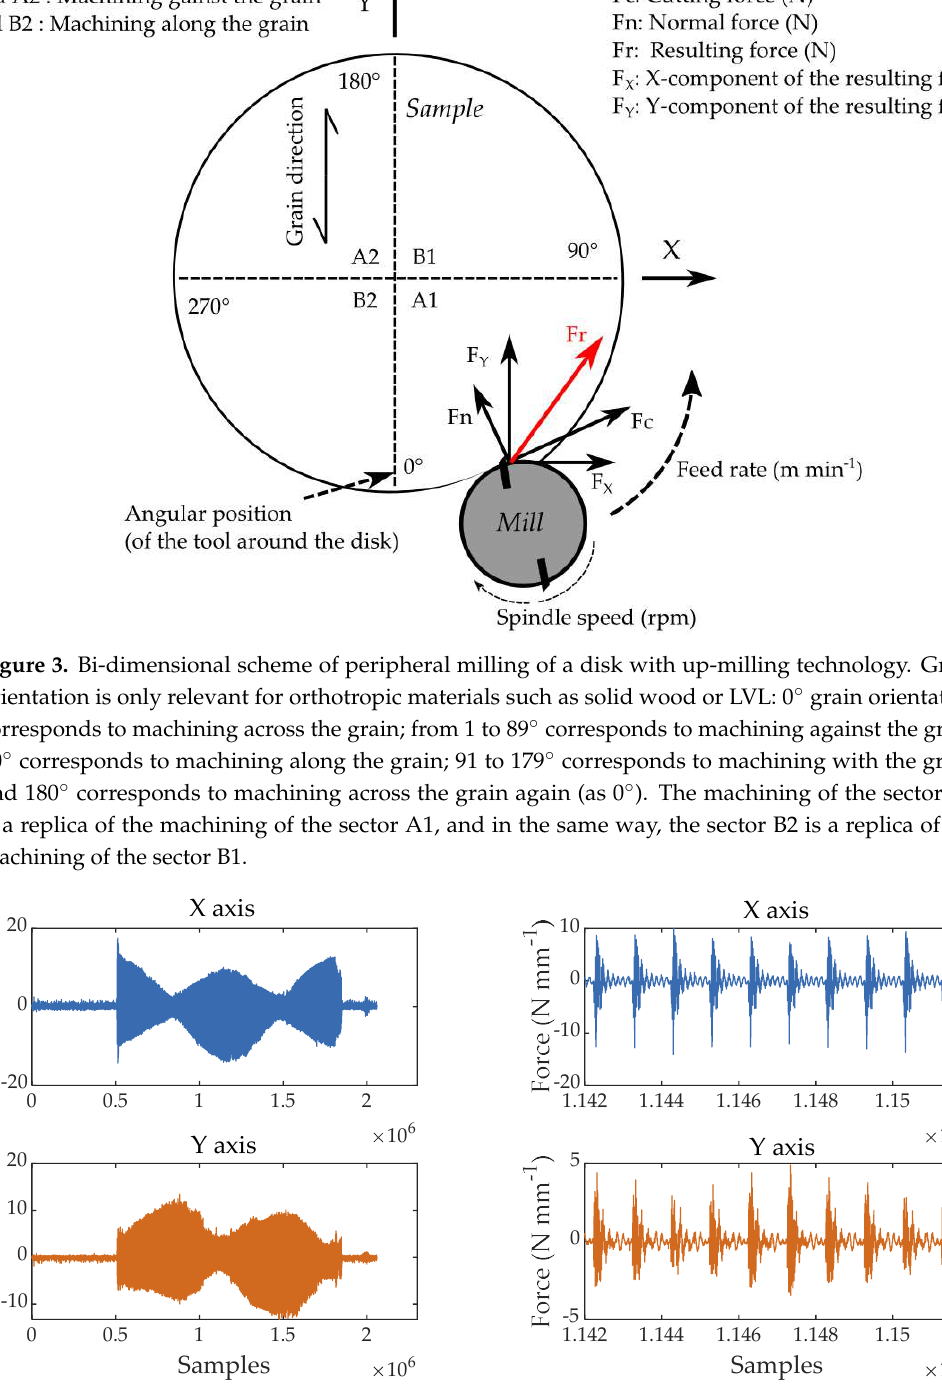
( b ) Figure 5. PTFE-machined up-milling with a depth of cut of 1.5 mm forces signals: ( a ) after applying a moving average on 10 cutting periods; ( b ) after applying a moving average on 10 cutting periods and a smoothing on 20 cutting periods. The signals after smoothing were also detrended. The initial and final part of the signals were then removed in order to keep only the cutting forces during the disk machining and the resultant force was computed according to Equation (1): 𝐹𝑟 = (cid:3493)𝐹 (cid:3025)(cid:2870) + 𝐹 (cid:3026)(cid:2870) .